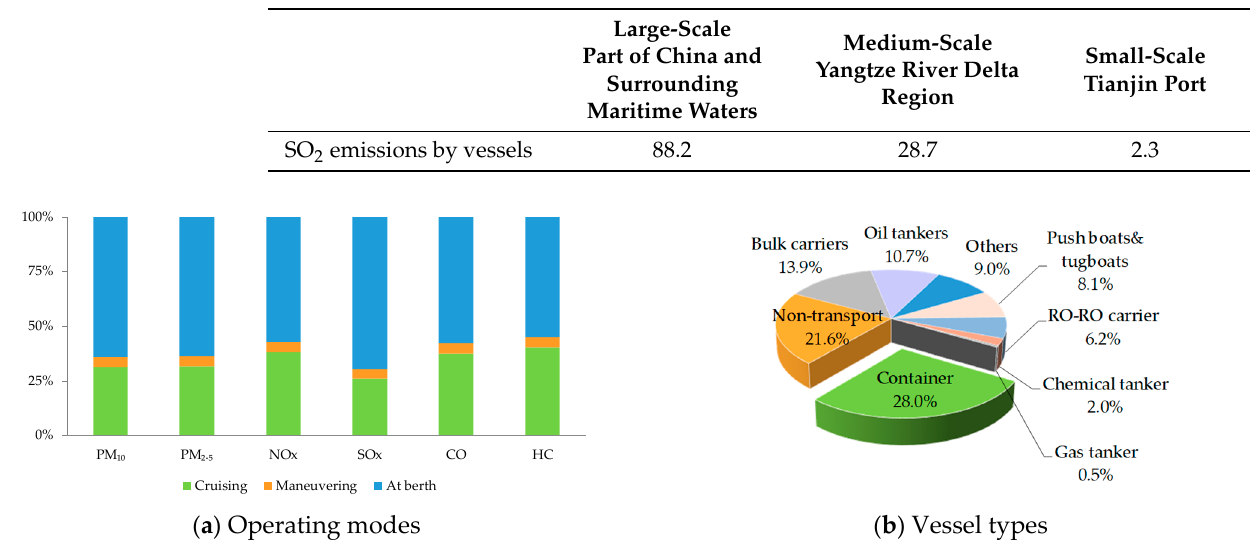
Table 3. Computed results of SO 2 emissions by vessels in Method 2. Unit: 10 4 t.